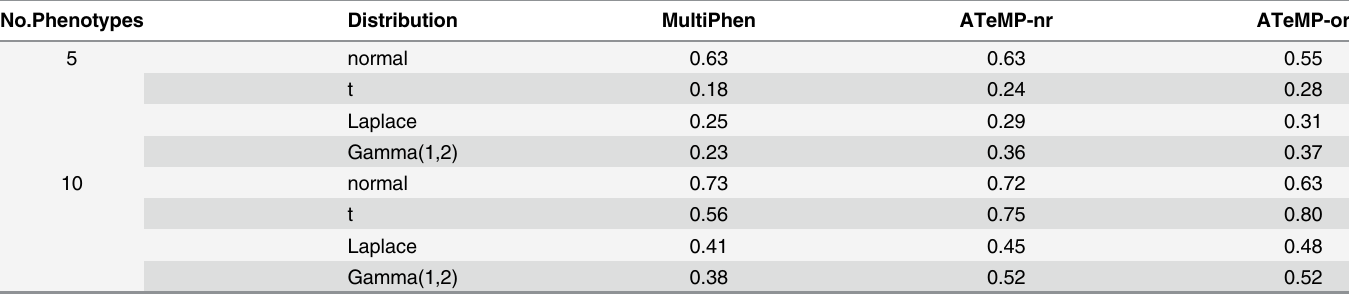
Table 1. The power of the multiple phenotypes association tests at the significance level 5 × 10 − 4 when the number of phenotypes are 5 and